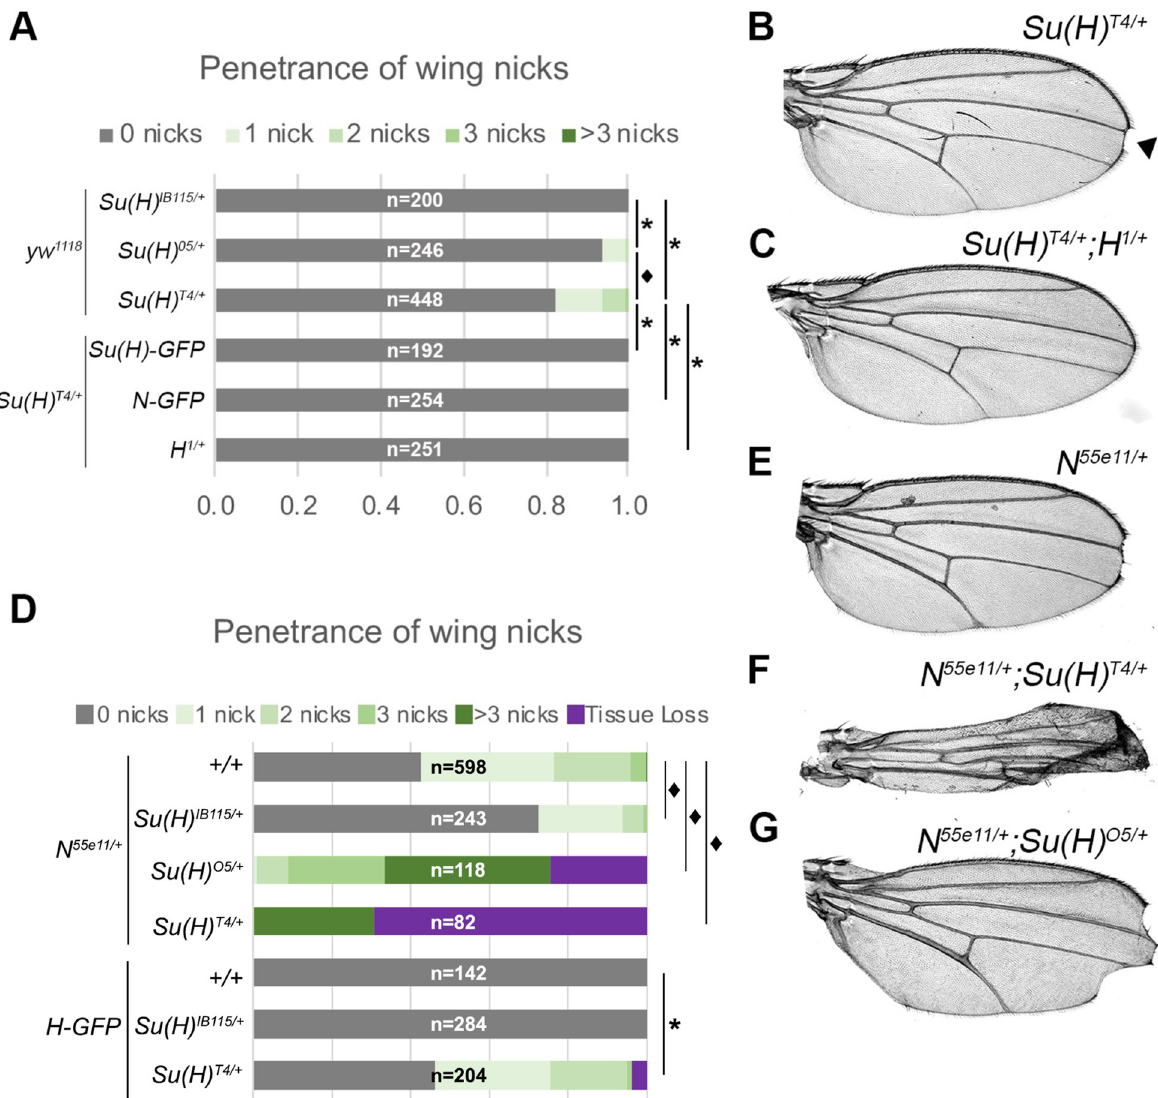
Fig 3. AOS-like Su(H) alleles induce wing nicking phenotypes that can be enhanced or suppressed by genetic changes in the Notch signaling pathway. A . Quantified wing nicking in the indicated genotypes with number of wings analyzed (n) noted on each bar graph. Flies used in the top three bars were generated by crossing the yw 1118 stock that is WT for Su(H) with flies carrying each of the indicated Su(H) alleles. Flies used in the bottom three bars were generated by crossing flies carrying a Su(H) T4 allele with flies carrying either the Su(H)-GFP BAC, the Notch-GFP BAC, or the H 1 null allele, as indicated. Proportional odds model with Bonferroni adjustment tested for penetrance/severity differences between Su(H) O5/+ and Su(H) T4/+ flies with denoting p < 0.01. Two-sided Fisher’s exact test was used to assess all other genotypes with � denoting p < 0.01. B-C . A wing from a Su(H) T4/+ heterozygote in an otherwise WT background (B) or in combination with a H 1/+ heterozygous background ( Su(H) T4/+ ; H 1/+ , C). Note, the Su(H) T4/+ wing had a nick (black arrowhead), whereas all the wings from Su(H) T4/+ ; H 1/+ flies did not have wing nicks. D . Quantified wing notching in the indicated genotypes with number of wings analyzed (n) noted on each bar graph. Flies used in the top four bars were generated by crossing N 55e11/+ female flies with either yw 1118 WT male flies or male flies carrying the indicated Su(H) alleles. Flies used in the bottom three bars were generated by crossing flies carrying the Hairless-GFP (H-GFP) BAC rescue with either yw 1118 WT flies or flies carrying the indicated Su(H) alleles. Two-sided Fisher’s exact test was used to assess penetrance differences between flies with � denoting p < 0.01. E-G . Wings from female flies containing a copy of the N 55e11 allele in either a WT (E), Su(H) T4/+ (F) or Su(H) O5/+ (G) background. Note, the severe nicking and morphological wing phenotypes observed in the compound